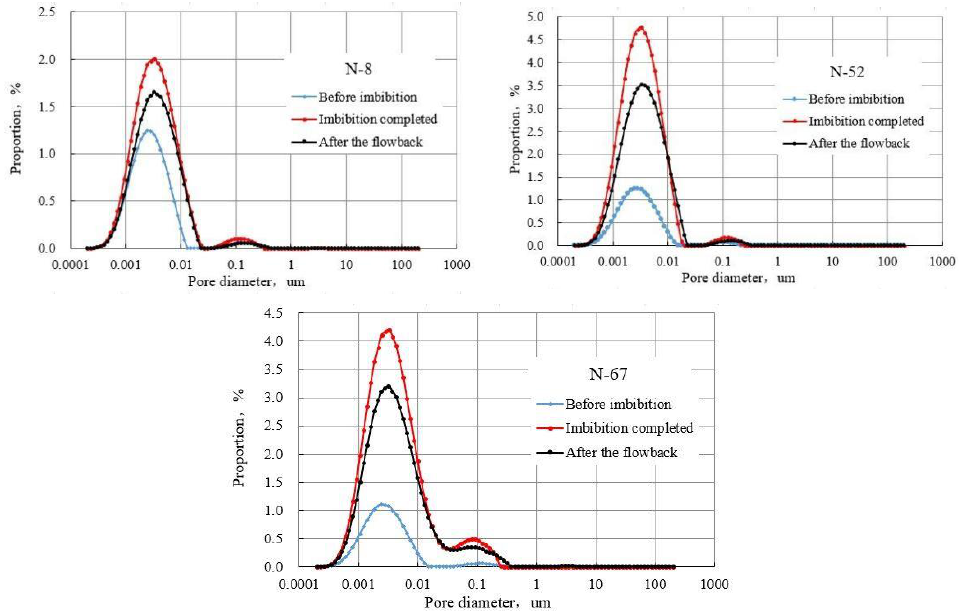
Figure 7. Shale NMR measurement results before imbibition, imbibition completed and after the flowback.